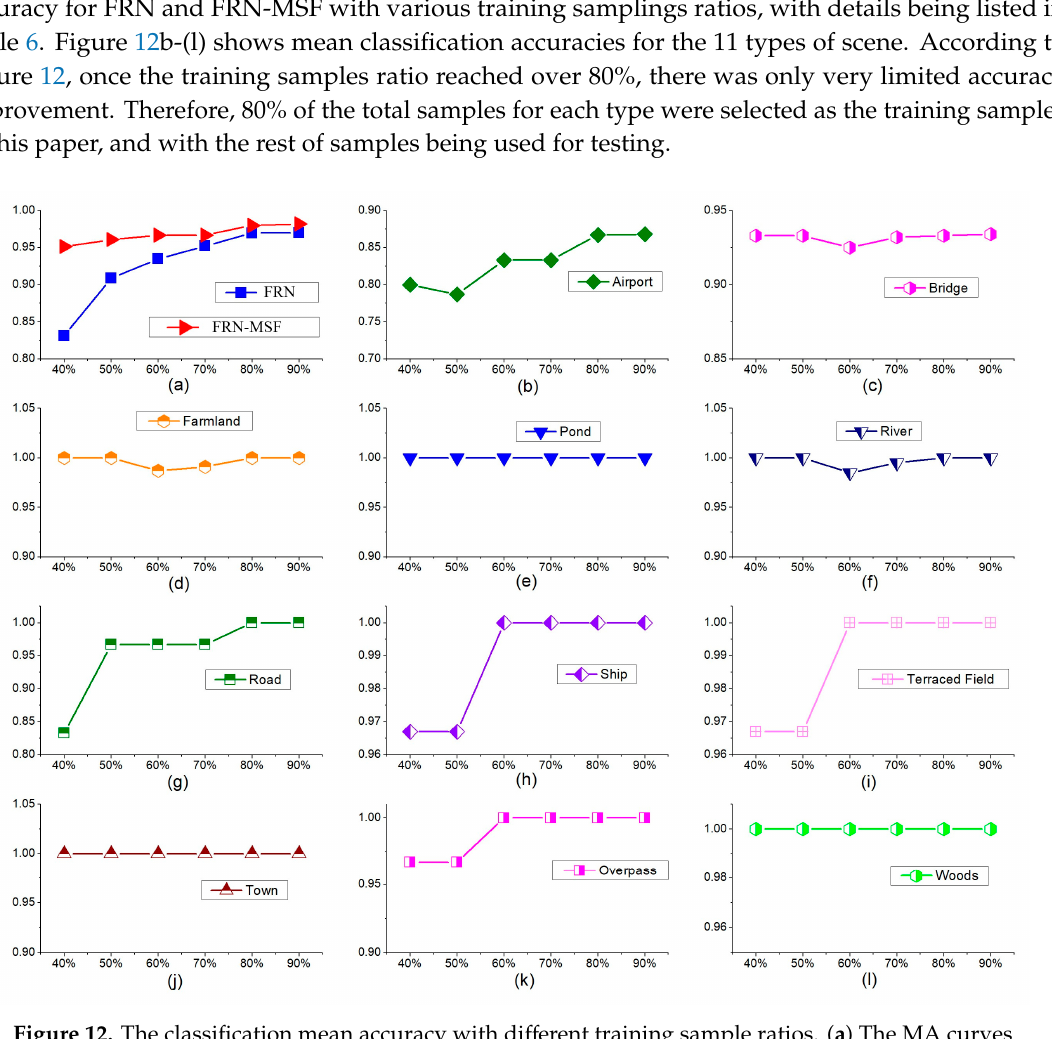
Figure 12. The classification mean accuracy with different training sample ratios. ( a ) The MA curves for FRN and FRN-MSF with training sample ratios; ( b ) The MA curves for Airport with training sample ratios; ( c ) The MA curves for Bridge with training sample ratios; ( d ) The MA curves for Farmland with training sample ratios; ( e ) The MA curves for Pond with training sample ratios; ( f ) The MA curves for River with training sample ratios; ( g ) The MA curves for Road with training sample ratios; ( h ) The MA curves for Ship with training sample ratios; ( i ) The MA curves for Terraced Field with training sample ratios; ( j ) The MA curves for Town with training sample ratios; ( k ) The MA curves for Overpass with training sample ratios; ( l ) The MA curves for Woods with training sample ratios.